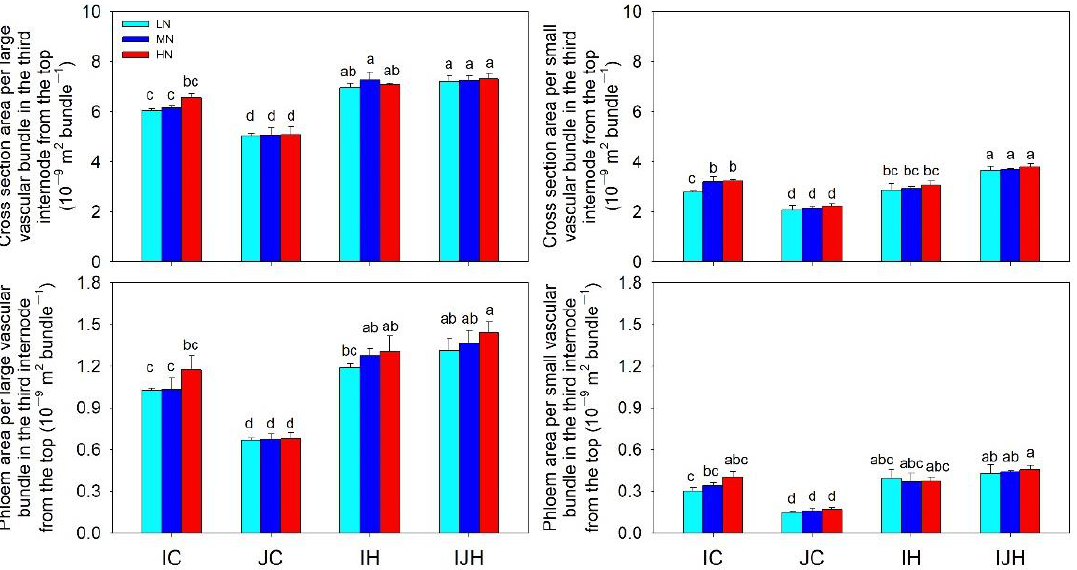
Figure 6. Cross sectional areas and phloem areas of large and small vascular bundles of the third internode from the top of different rice varieties under different nitrogen application levels. Different letters on top of histograms indicate significant differences at p < 0.05 among different rice varieties under different nitrogen application levels. IC, indica conventional rice; JC, japonica conventional rice; IH, indica hybrid rice; IJH, indica-japonica hybrid rice; LN, low nitrogen; MN, medium nitrogen; HN, high nitrogen.